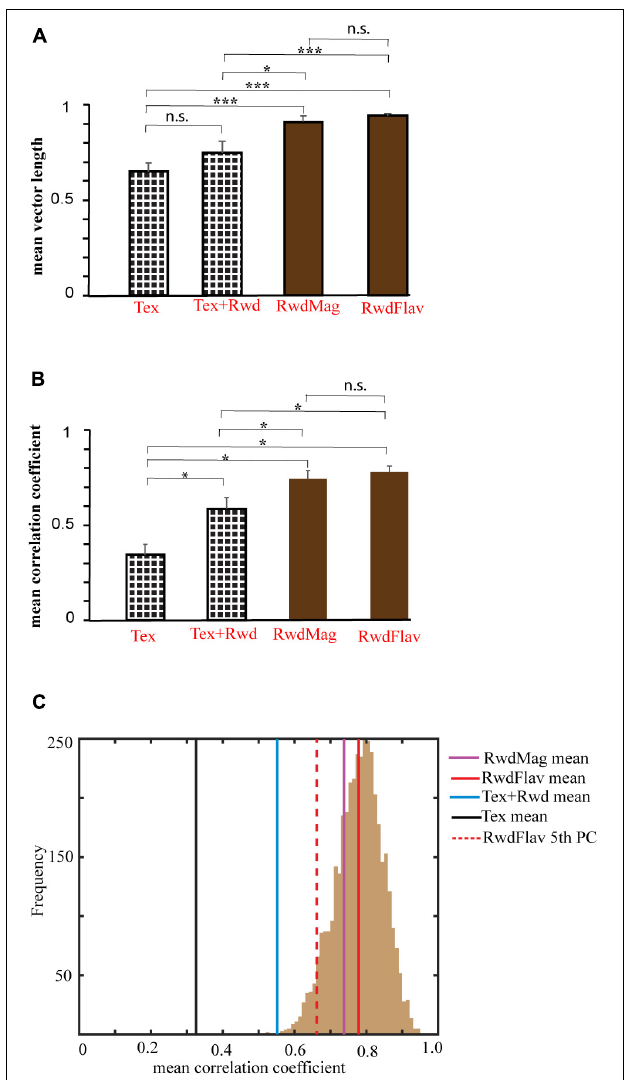
FIGURE 11 | Comparison of mean vector length and correlation coefficient across different experiments. (A) Mean vector length of mismatch sessions in different experimental paradigms. The error bar indicates the standard error of the mean. n.s indicates non-significant. * indicates p < 0.02, *** indicates p < 0.001 (Kruskal–Wallis test, Bonferroni corrected). (B) Mean correlation coefficient obtained from a spatial coupling between subsequent sessions in different experimental paradigms. * indicates p < 0.05, n.s. indicates non-significant. (Kruskal–Wallis test, Bonferroni corrected). (C) Histogram of coefficient of correlation calculated by the bootstrap sampling of any random 200 cell pairs between adjacent sessions (1,000 repetitions) in the RwdFlav experiment. The red-dotted line and the solid red line indicate the 5th percentile and the mean of the correlation coefficient obtained (RwdFlav experiments). Mean correlation coefficients of other experiments obtained by bootstrap sampling are also shown. The mean correlation of Tex and Tex + Rwd experiments is lower than the 5th percentile of RwdFlav experiments ( p <